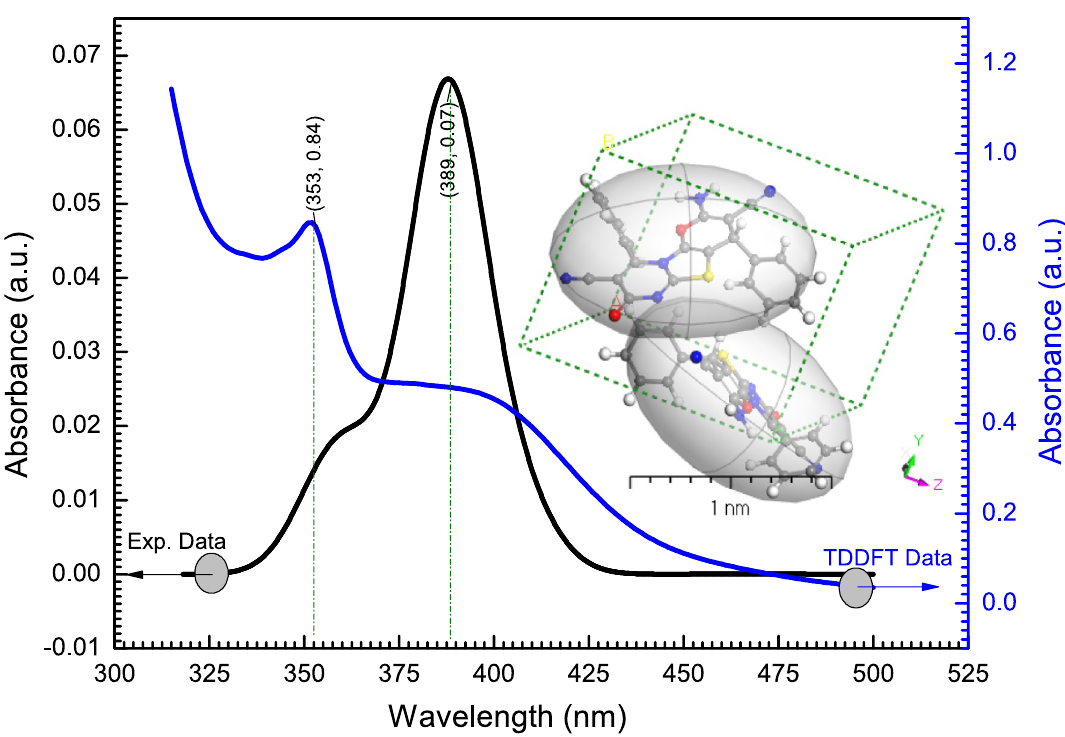
Figure 7. The absorbance spectra of [ThiPy-3,8-Dc] TF thin film (Experimental part) and [ThiPy-3,8-Dc] Iso as an isolated molecule in the gaseous state using TD-DFT/DMOl 3 Technique. The inset figure is a 3D Triclinic lattice-type computed using the polymorph method.